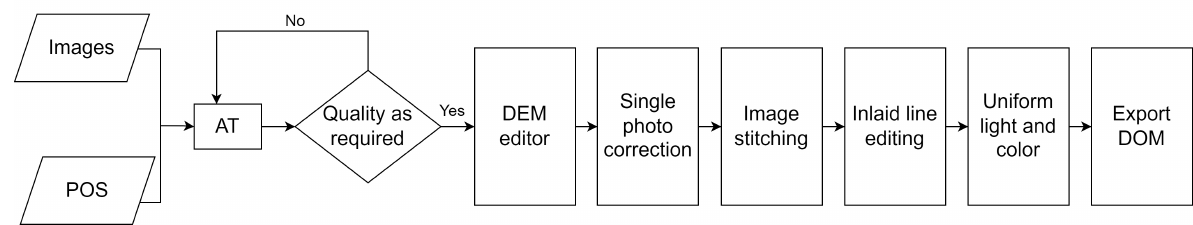
Figure 7. Production of